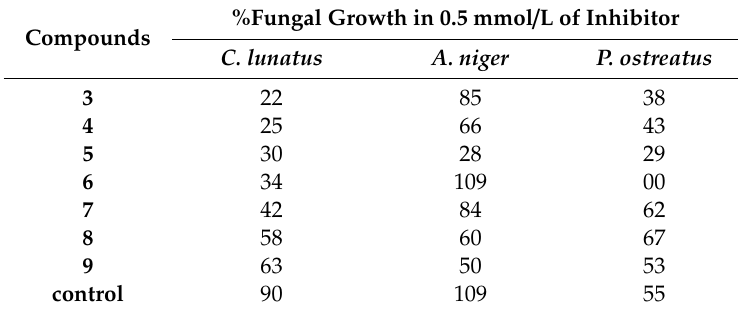
Table 1. Comparing percentage fungal growth of the three fungi when treated with 0.5 mmol/L of cinnamic acid derivatives ( 3–9 ) [22].